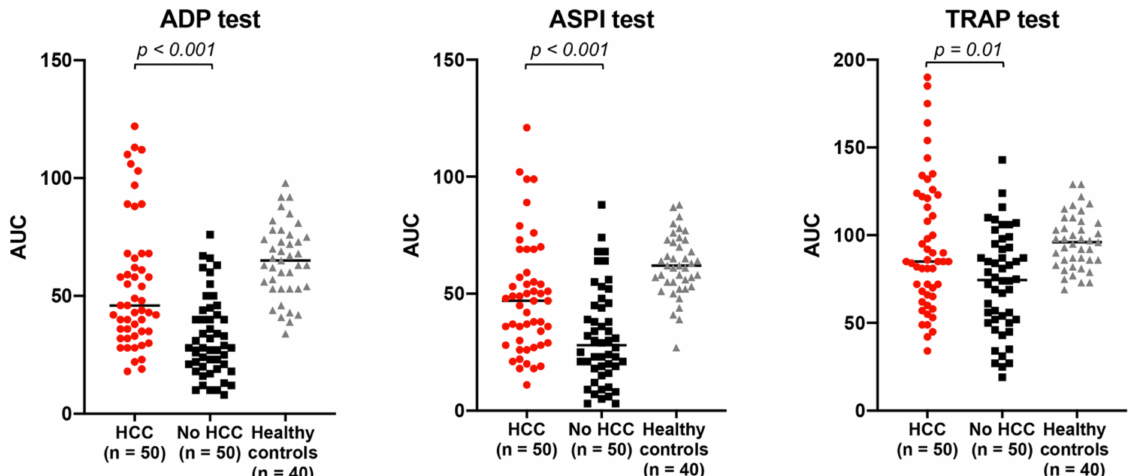
Figure 2. Platelet induced aggregation is significantly increased in patients with cirrhosis with vs. without HCC. Legend: HCC: hepatocellular carcinoma; ADP: adenosine diphosphate; ASPI: arachidonic acid pathway test; TRAP: thrombin receptor agonist peptide. Red circles: patients with cirrhosis with HCC. Black squares: patients with cirrhosis without HCC. Grey triangles: healthy